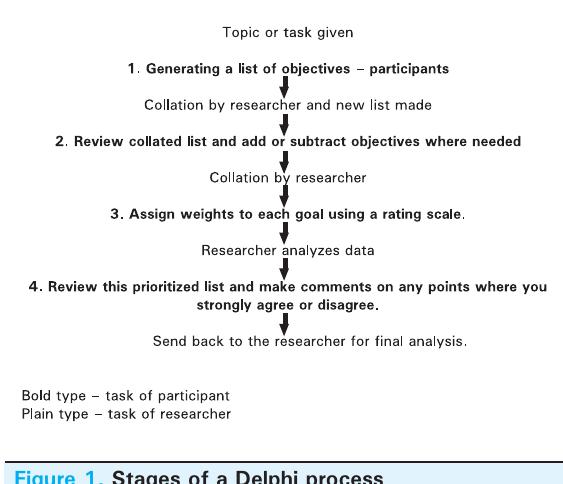
Figure 1. Stages of a Delphi process Two researchers independently reviewed the list of objectives generated by the group in step one, and identifi ed common